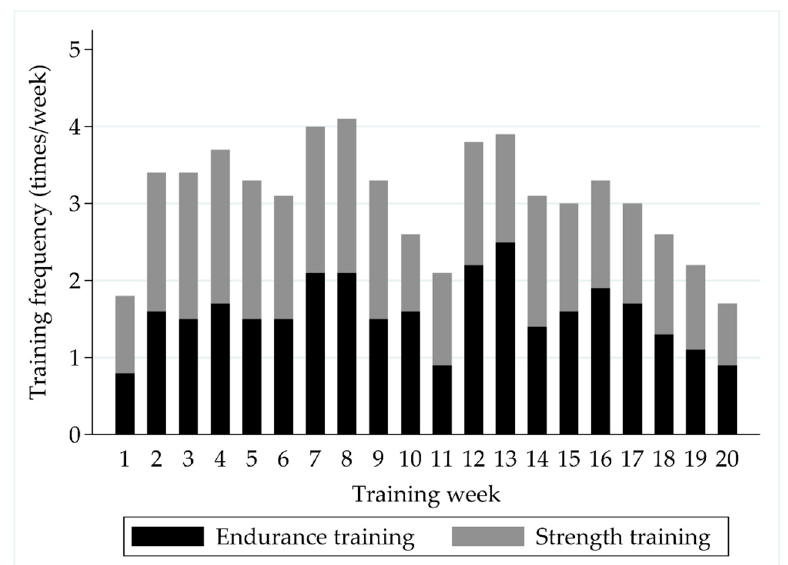
Figure 2. The distribution of self-reported weekly strength and endurance training sessions during the follow-up.